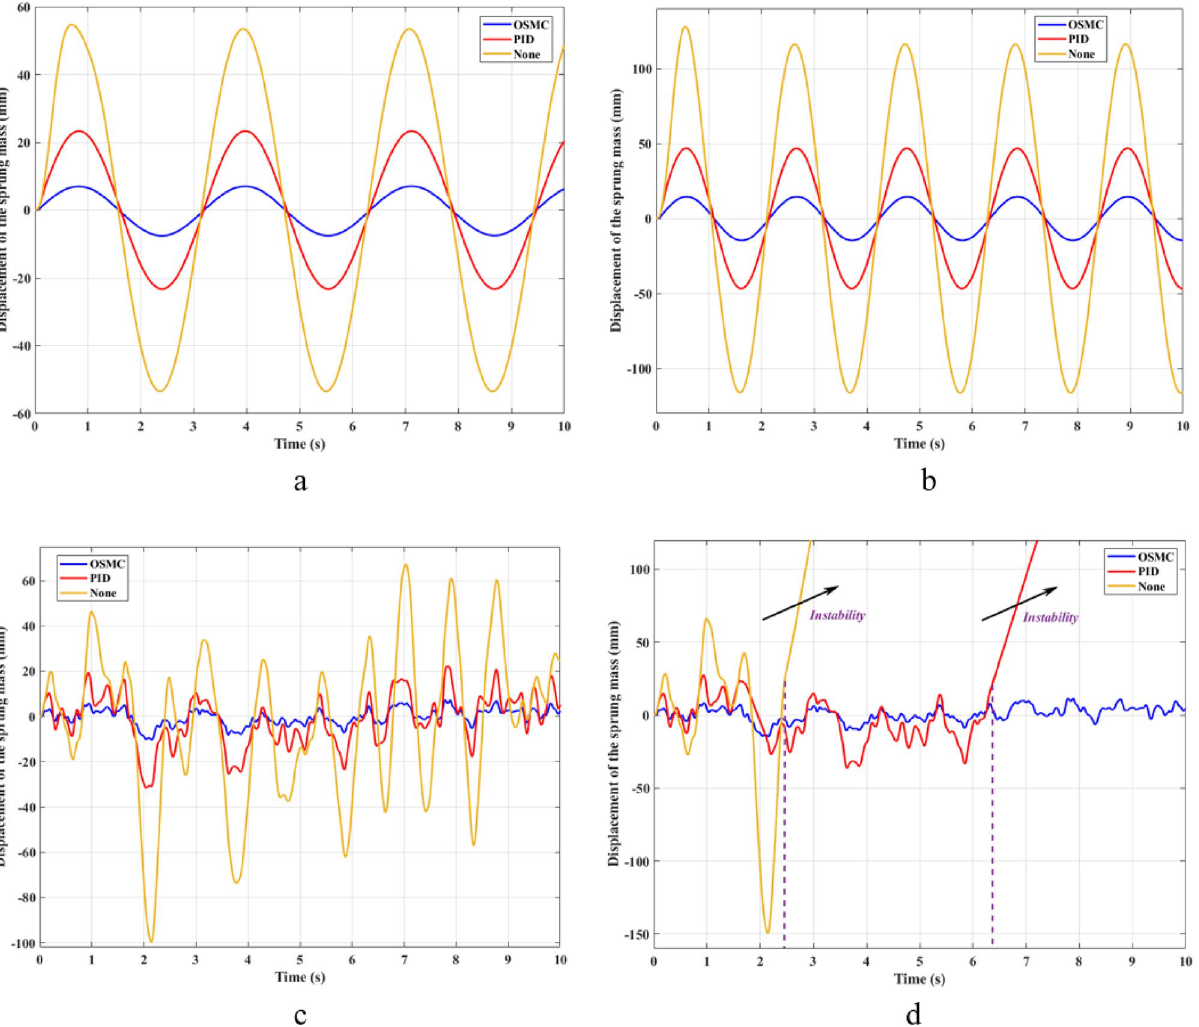
Figure 4. Displacement of the sprung mass (( a ) Case 1; ( b ) Case 2; ( c ) Case 3; ( d ) Case